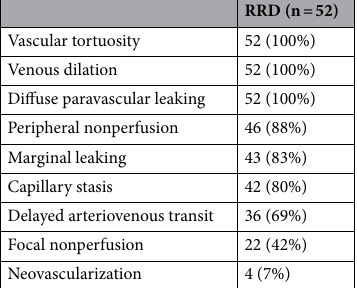
Table 3. Perfusion impairment and vascular abnormalities detected in preoperative ultra-widefield fluorescein angiography in rhegmatogenous retinal detachment. RRD rhegmatogenous retinal